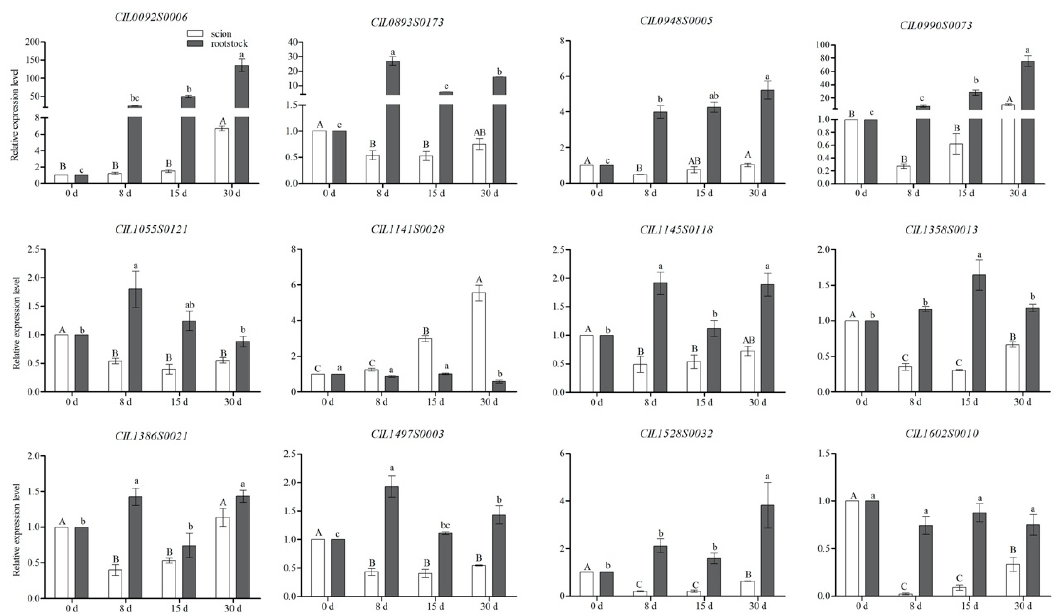
Figure 8. Quantification of expression levels of pecan R2R3-MYBs after grafting using qRT-PCR. One-year-old pecan trees were cultured as rootstocks, and Pawnee cultivar was used as scion. After grafting, samples from rootstock and scion close to the graft interface were collected at 0 (control), 8, 15 and 30 d. The actin gene ( CIL1155S0051 ) was applied as a reference gene. Values are means ± Standard Error (SE) of three biological replicates, and different letters reveal significant difference ( p < 0.05) according to Duncan’s test.